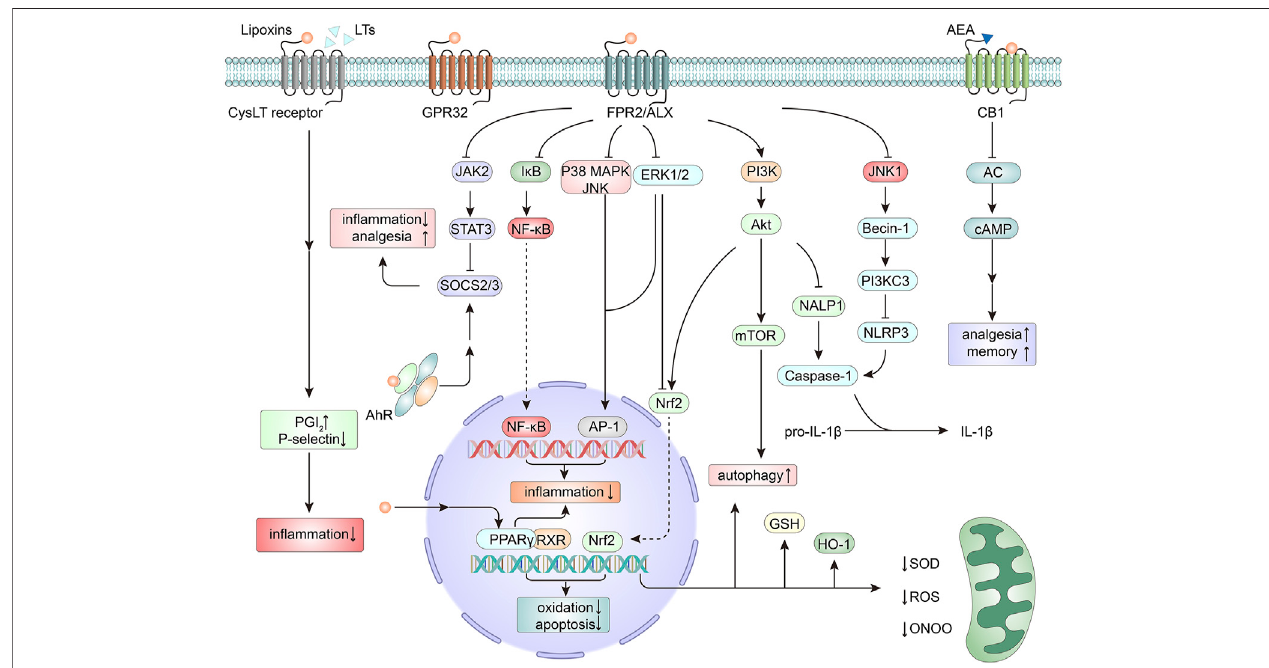
FIGURE 1 | Mechanisms of neuroprotection by lipoxins (LXs). The actions of LXs are mainly mediated by the activation of the formyl peptide receptor 2/LXA 4 receptor (FPR2/ALX). Downstream from the activation of FPR2/ALX, several signaling pathways are triggered, thus modulating the expression of genes and proteins relatedtoin fl ammation(Machadoetal.,2006;Wangetal.,2011;Wangetal.,2014),apoptosis(Zhuetal.,2020),oxidation(Wuetal.,2012c;Jinetal.,2014),autophagy (Prietoetal.,2015),andpainsignaling(Wangetal.,2014).Asantagonistsofcysteinylleukotriene(CysLT)receptors,LXscompeteforbindingsiteswithleukotrienes (LTs) and mediate an anti-in fl ammatory action (Norel and Brink, 2004). LXs can bind to G protein-coupled receptor 32 (GPR32) (Zhu et al., 2016) and act as an endogenous allosteric enhancer of the cannabinoid 1 (CB1) receptor (Pamplona et al., 2012). LXs can also exert agonistic action on peroxisome proliferator-activated receptor gamma (PPAR γ ) (Sobrado et al., 2009), thereby mitigating in fl ammation and neutralizing oxidative stress. In addition, by activating the nuclear receptor aryl hydrocarbon receptor (AhR), LXs promote the expression of suppressor of cytokine signaling 2 (SOCS2), thus exerting effects on anti-in fl ammation and analgesia (Schaldachetal.,1999;Machadoetal.,2006).AC,adenylatecyclase;AEA,anandamide;Akt,proteinkinaseB,PKB;AP-1,activatingprotein-1;cAMP,cyclicadenosine monophosphate;ERK,extracellularsignalregulatedkinase;GSH,glutathione;HO-1,hemeoxygenase-1;I κ B,inhibitor κ B;JAK2,Januskinase2;JNK,c-JunN-terminal kinase; MAPK, mitogen-activated protein kinase; mTOR, mammalian target of rapamycin; NALP1, NAcht leucine-rich-repeat protein 1; NF- κ B, nuclear factor kappa B; Nrf2,nuclearfactor erythroid2-related factor2;ONOO,peroxynitrite;PG,prostaglandin;PI3K,phosphoinositide-3-kinase; ROS,reactiveoxygenspecies; RXR,retinoid X receptor; SOD, superoxide dismutase; STAT3, signal transducer and activator of transcription 3.